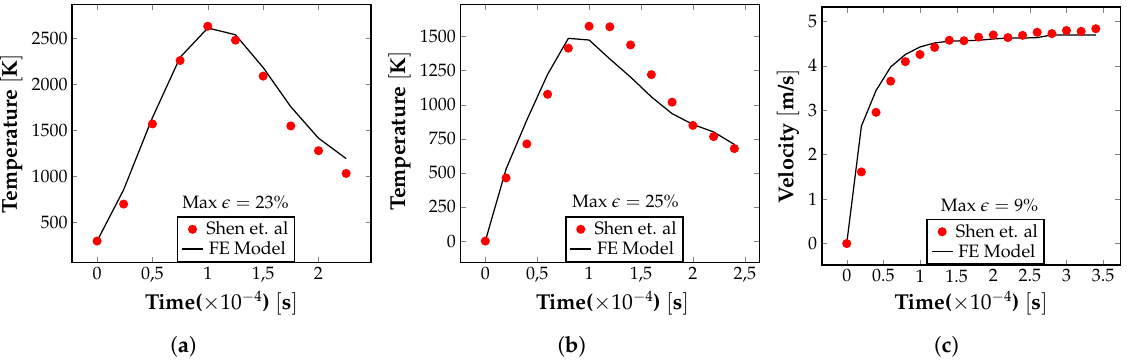
Figure 4. Validation of the FE model results by comparing with corresponding values reported in the literature. ( a ) Variation in point temperature with time for the case P = 200 W. ( b ) Variation in point temperature with time for the case P = 100 W. ( c ) Variation in maximum pool velocity with time for the case P = 100 W